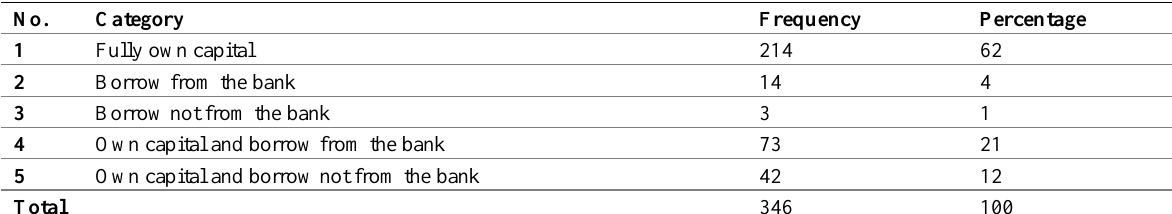
Table 8: Sources of Business Capital